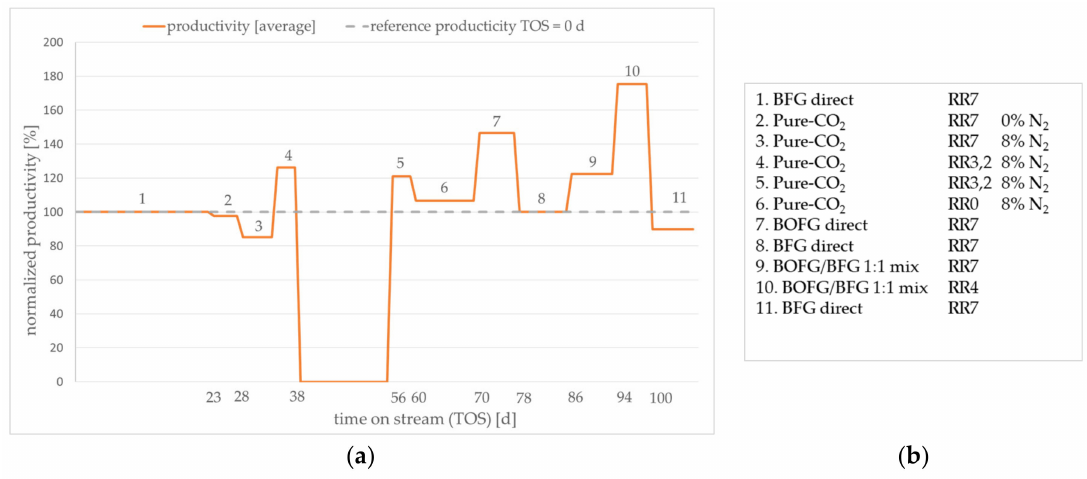
Figure 9. Practical test results of the considered case scenarios ( a ) and the order of the performed tests ( b